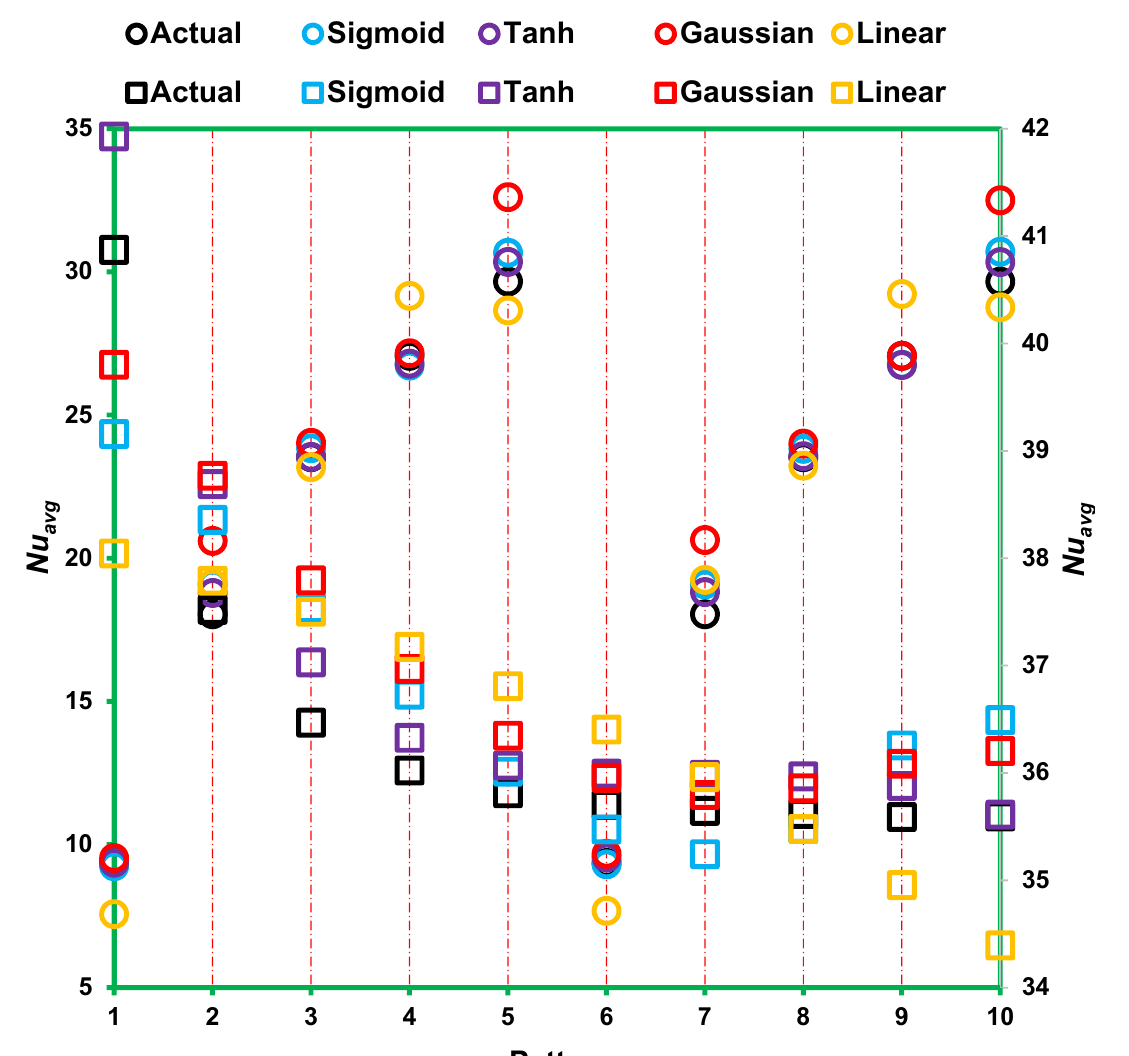
Figure 15. Training (circles) and testing (squares) made by the deep NN models optimized from four activations functions compared to actual battery data.